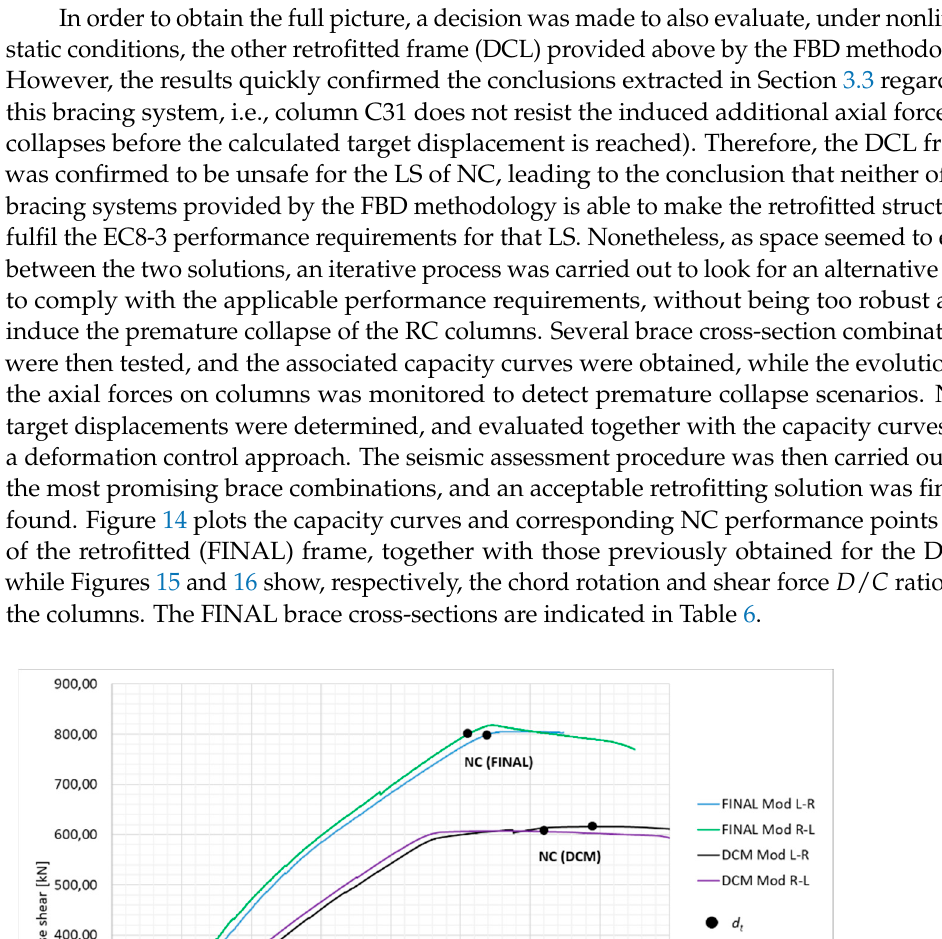
Figure 15. FINAL: NC chord rotation 𝐷 𝐶⁄ ratios on columns (pushover analysis). Figure 16. FINAL: NC shear force 𝐷 𝐶⁄ ratios on columns (pushover analysis).